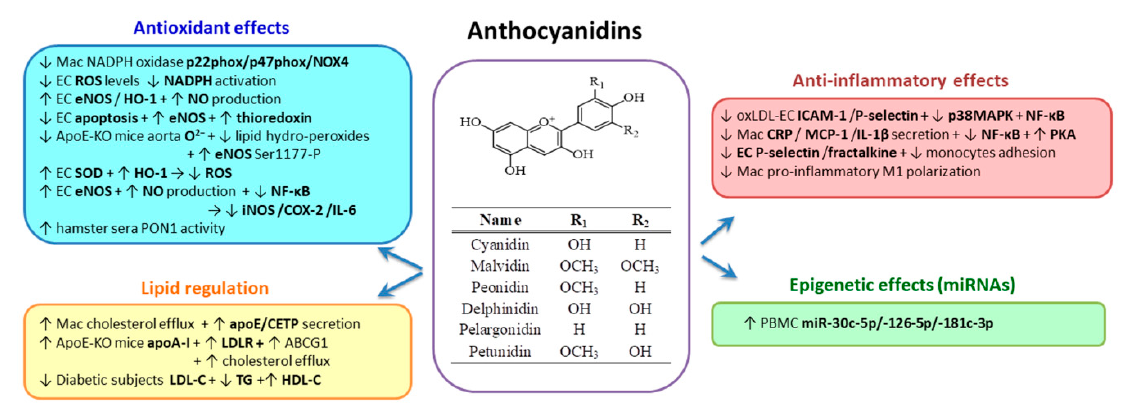
Figure 8. Anthocyanidins’ classifications, chemical structures and beneficial effects for improving cardiovascular disease outcomes.